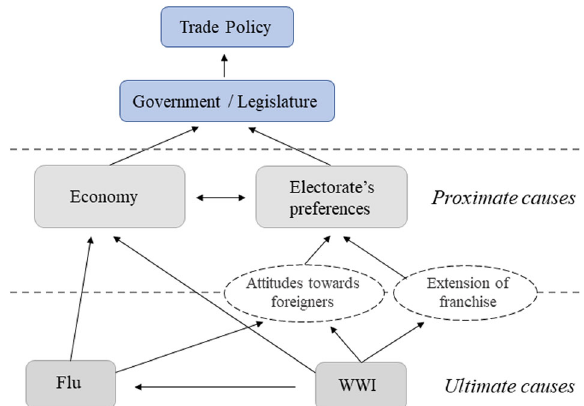
Fig. 1 Flowchart of the suggested mechanisms. Overview of the suggested mechanisms between the First World War, the Spanish Flu, and tariffs; see text for